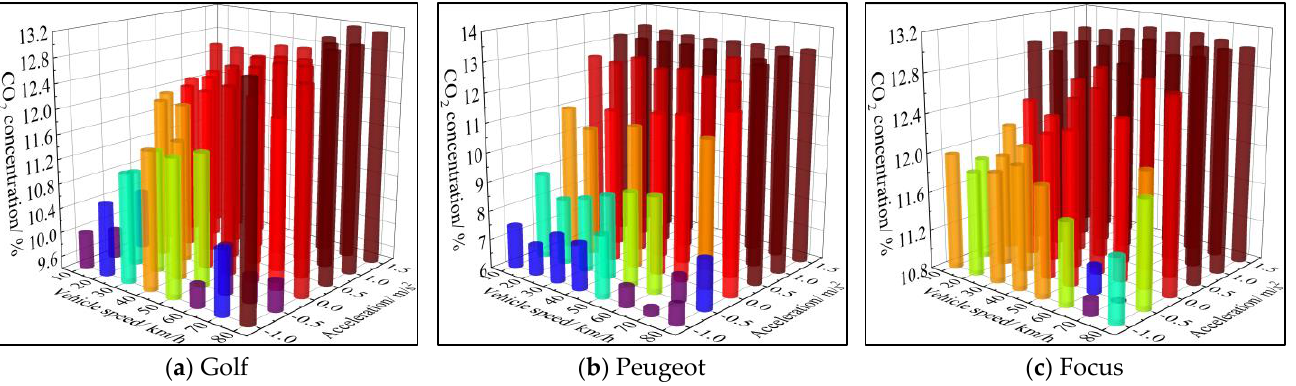
Figure 11. CO 2 concentration vs. vehicle speed and acceleration.